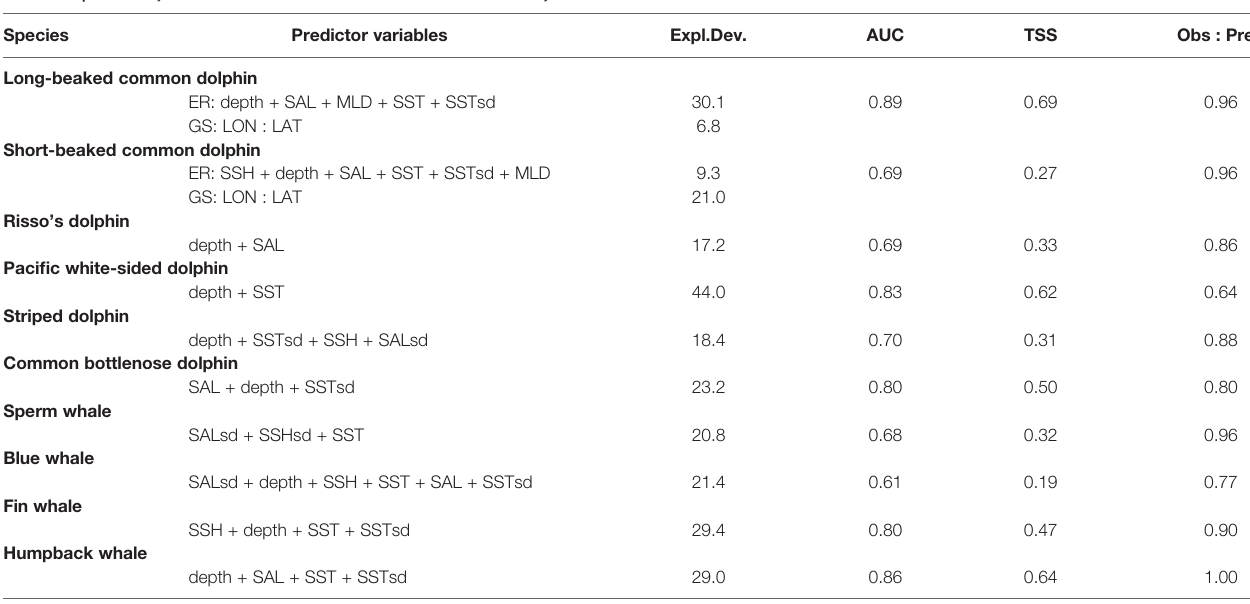
TABLE 3 | Summary of the fi nal models built with the 1992 – 2018 survey data.